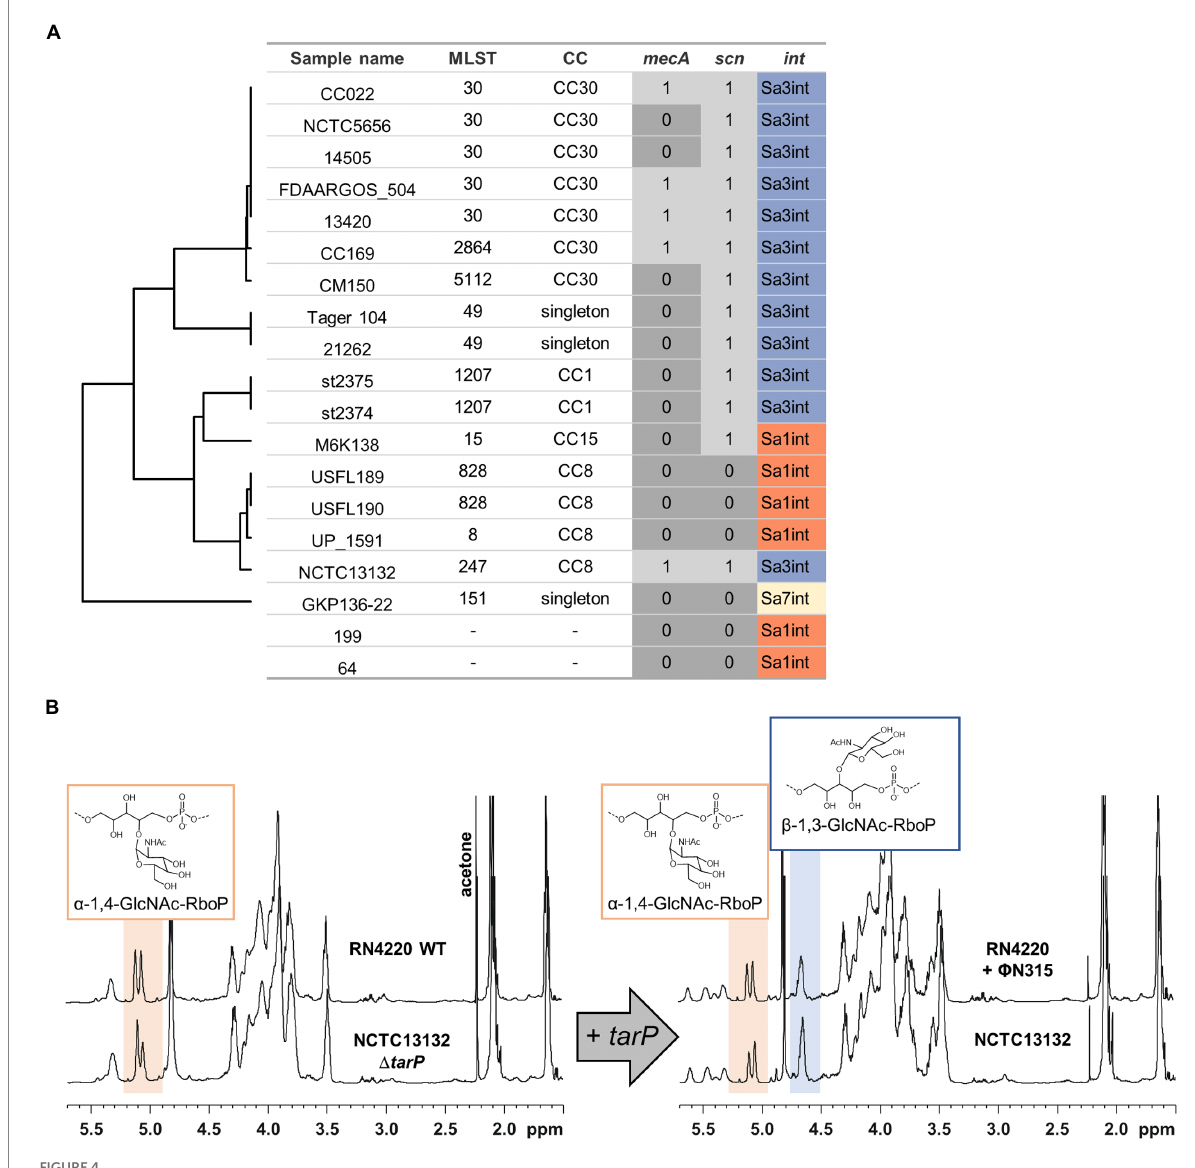
FIGURE 4 Identified S. aureus encoding tarP and tarM . MRSA determinant mecA , IEC, and tarP -associated integrase are indicated. (A) Isolates are grouped by MLST similarity as in Figure 3B (in 2 cases MLST could not be determined). (B) 1H-NMR spectra of tarM -positive S. aureus without (left) or with tarP (right), switching WTA glycosylation from a TarM-type ( α -1,4-GlcNAc-RboP) to a TarM/TarP-type ( α -1,4-GlcNAc-RboP + β